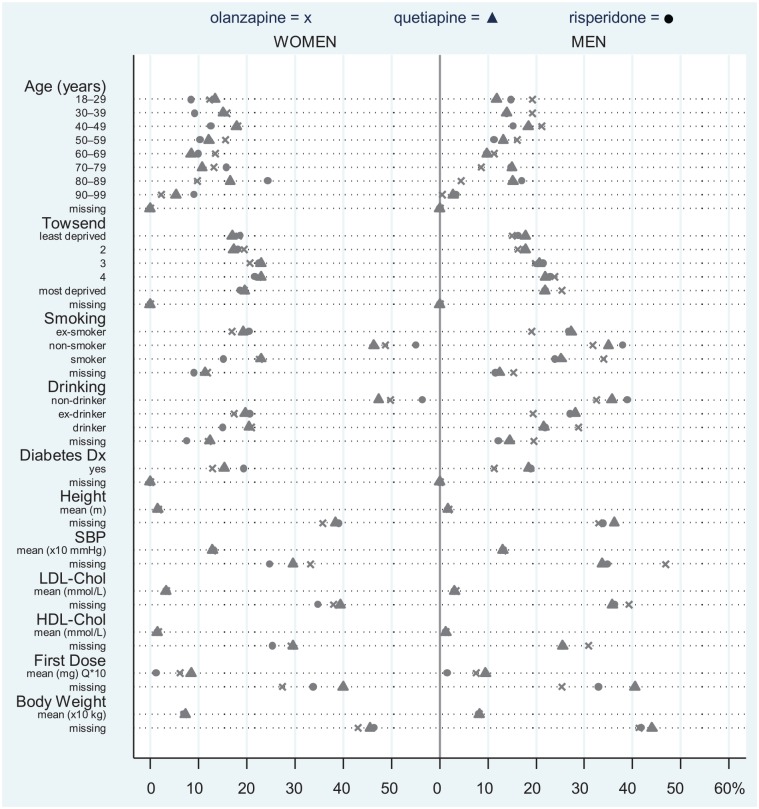
Baseline characteristics of patients from olanzapine, quetiapine and risperidone cohorts, stratified by sex. From height onwards, some continuous variables changed their scale as labelled below their names.